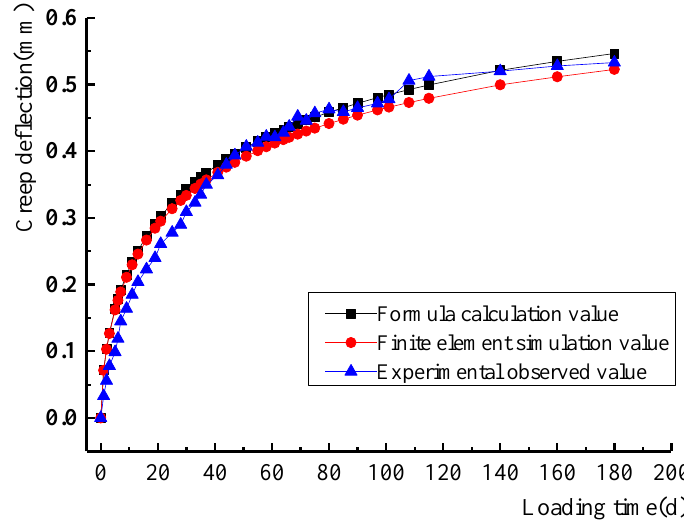
Figure 6. Creep-time curve of specimen TBB1.